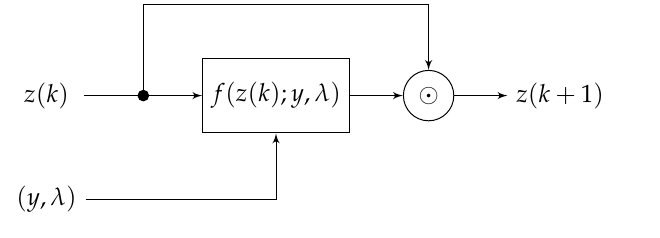
Figure 2. Structure of the optimizee Ω .